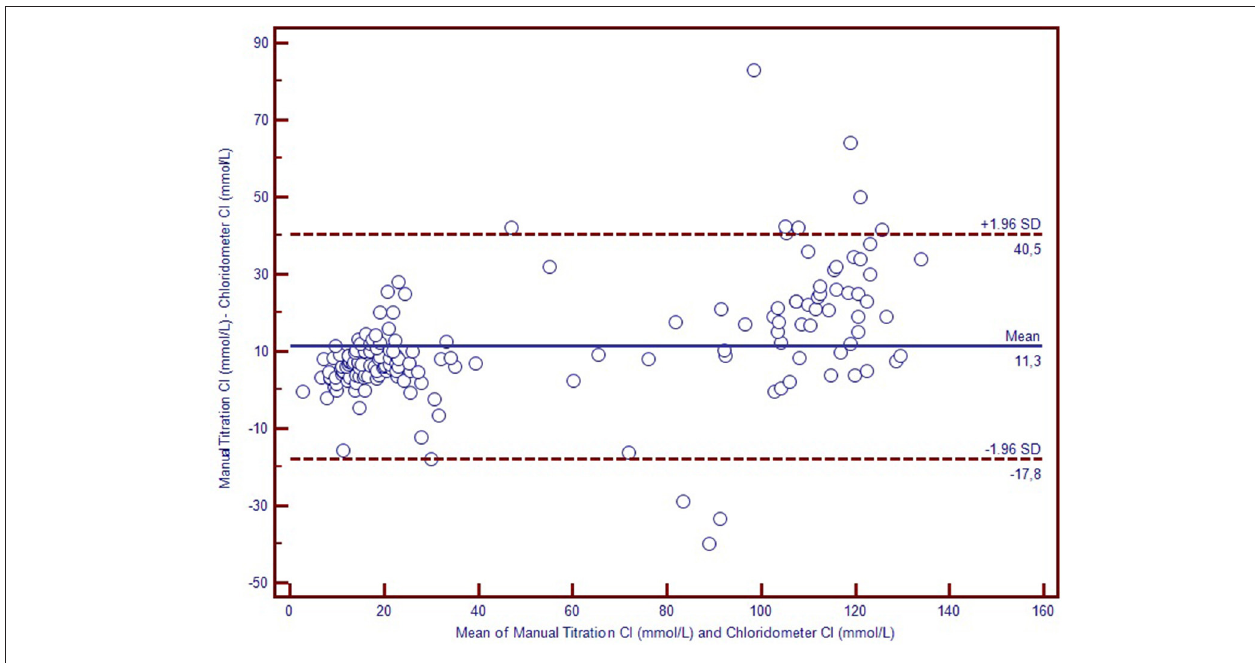
FIGURE 2 | Bland-Altman Plot of manual titration vs. chloridometer.